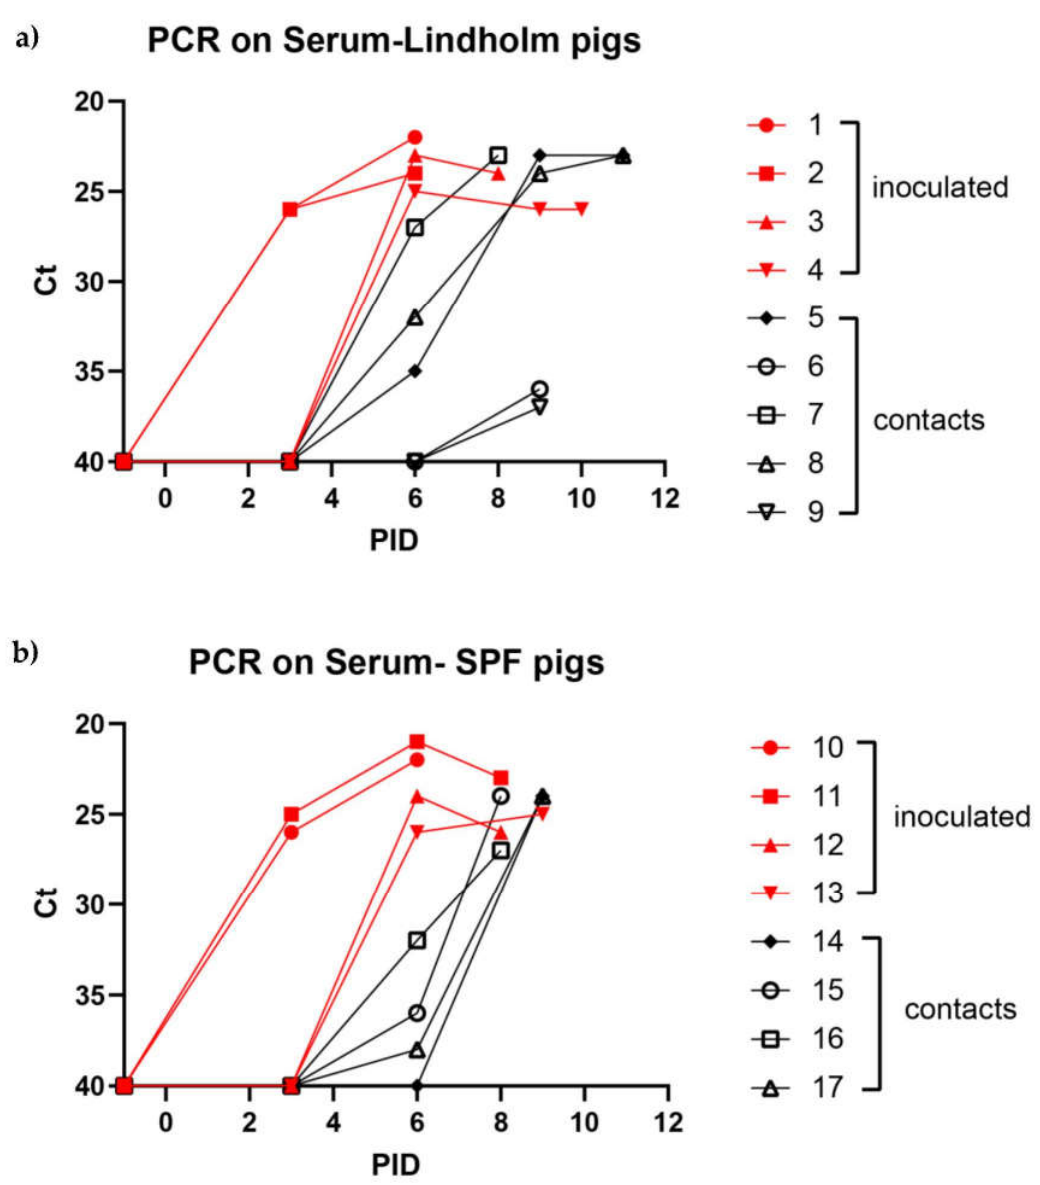
Figure 3. Detection of ASFV DNA in pig sera collected from animals obtained from Lindholm’s herd ( a ) or from a commercial supplier of SPF pigs ( b ). In each group of either Lindholm pigs (panel a) or SPF pigs (panel b), four pigs were inoculated (i.m. or i.n., as indicated) with ASFV Georgia/2007, and the remaining animals were kept in contact with the inoculated animals throughout the rest of the experiment. ASFV DNA was extracted from pig serum samples and assayed by qPCR. If no Ct value was obtained after 40 cycles, the sample was given a value of 40. Values are presented for the samples from inoculated and “in contact” animals collected on pre-selected days. Note: solid lines have been used to link the data points for the purpose of clarity but